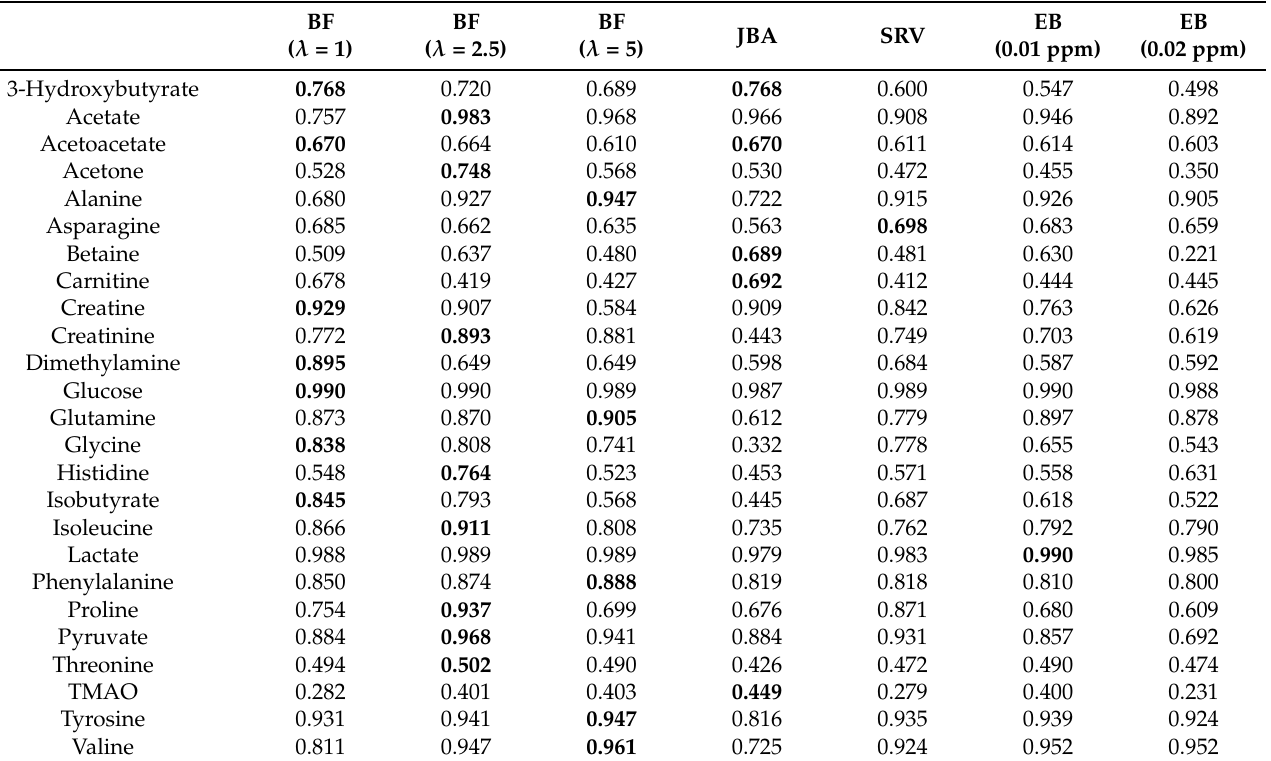
Table 2. The Spearman’s correlations to the absolutely quantified metabolite concentrations using BF with λ = 1, BF with λ = 2.5, BF with λ = 5, JBA, SRV, and the equidistant binning method with bin sizes of 0.01 ppm and 0.02 ppm. The highest correlations for each of the 25 metabolites are highlighted in bold.